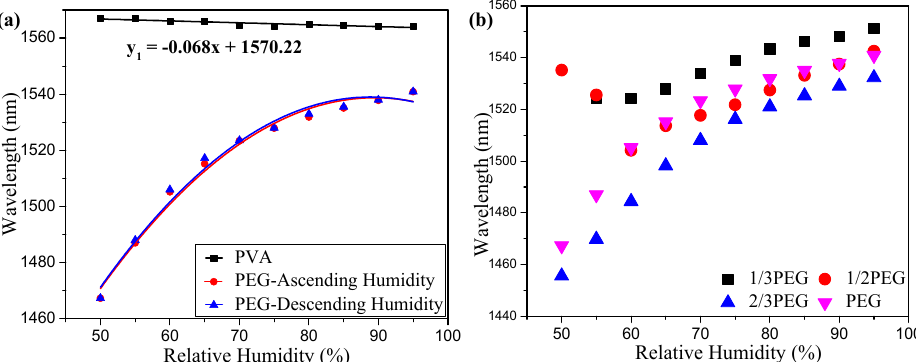
Figure 5. ( a ) A comparison of different materials for relative humidity sensing. ( b ) Humidity sensing characteristics of the LPFGs coated by the films with different PEG proportions in the humidity range from 50% to 95% RH.